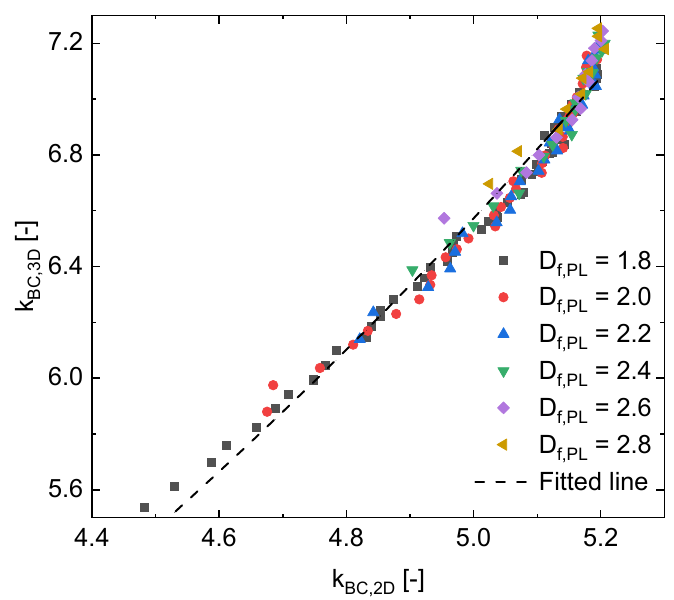
Figure 7. Relationship between k BC ,2 D and k BC ,3 D based on various D f , PL .